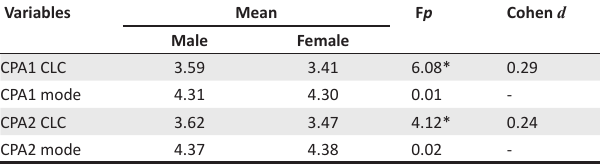
TABLE 4: Results of analysis of variance: Significant mean differences for gender groups. Variables